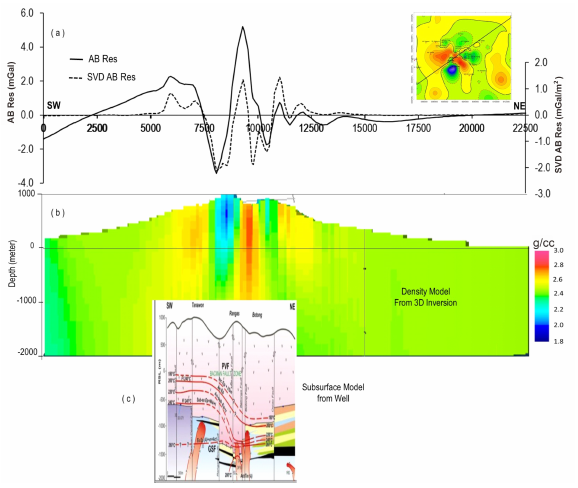
Fig. 14. The density distribution model of Bouguer Fig. 13. The cross-section of the density distribution model Residual anomaly 3D inversion modeling shows densities resulted from the Bouguer Residual anomaly 3D inversion 2.1 g/cc - 2.4 g/cc. The model is correlated with: which is correlated with the temperature and intrusion geothermal reservoir area boundaries delineated from the structure cross-sectional model for the NE-SW trajectory MT results, SVD = 0 maps, the division of geothermal [27]. areas, and volcanoes that control the geothermal system in the Bac-Man 13 . The 3D Bouguer anomaly residual inversion result, which correlated the temperature cross-section model and the intrusion structure, shows a good correlation. The pres- ence of intrusion correlates with high density in the area. Likewise, the SVD section indicates that the intrusion is no single but separated into two parts according to the model derived from well data and temperature data.